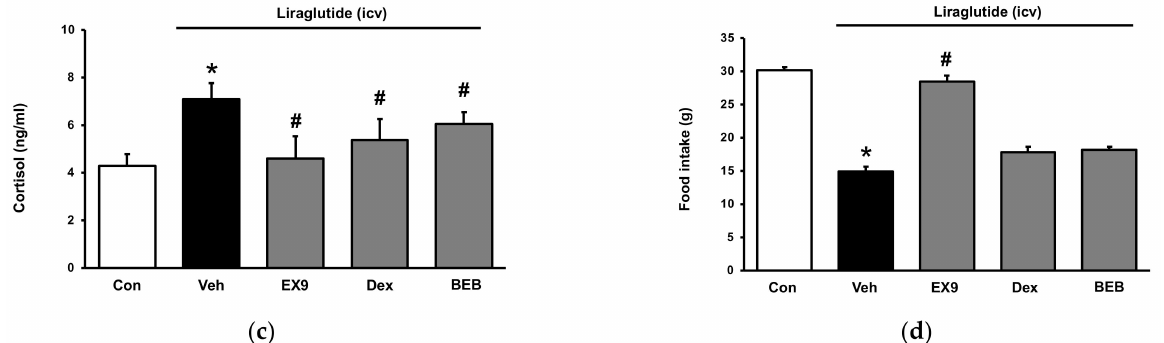
Figure 2. Effect of liraglutide on hypothalamic-pituitary-adrenal (HPA) axis in healthy rats. Liraglu- tide was injected into the brain directly and changes induced by liraglutide were compared with pretreatment of inhibitors including EX-9 (i.c.v.), berberine (BER, 200 mg/kg, i.p.) and dexamethasone (DEX, 5 µ g/kg, s.c.). Each inhibitor was pretreated by peripheral administration for 60 min, except EX-9, which was pretreated for 30 min by injection into the brain. ( a ) Changes in plasma glucose in rats; ( b ) Changes in plasma ACTH in rats; ( c ) Changes in plasma cortisol in rats; ( d ) Changes in feeding behavior in rats. The data are shown as means ± SEM ( n = 8). * p < 0.05 vs. normal control group; # p < 0.05 vs. vehicle (Veh)-treated group.